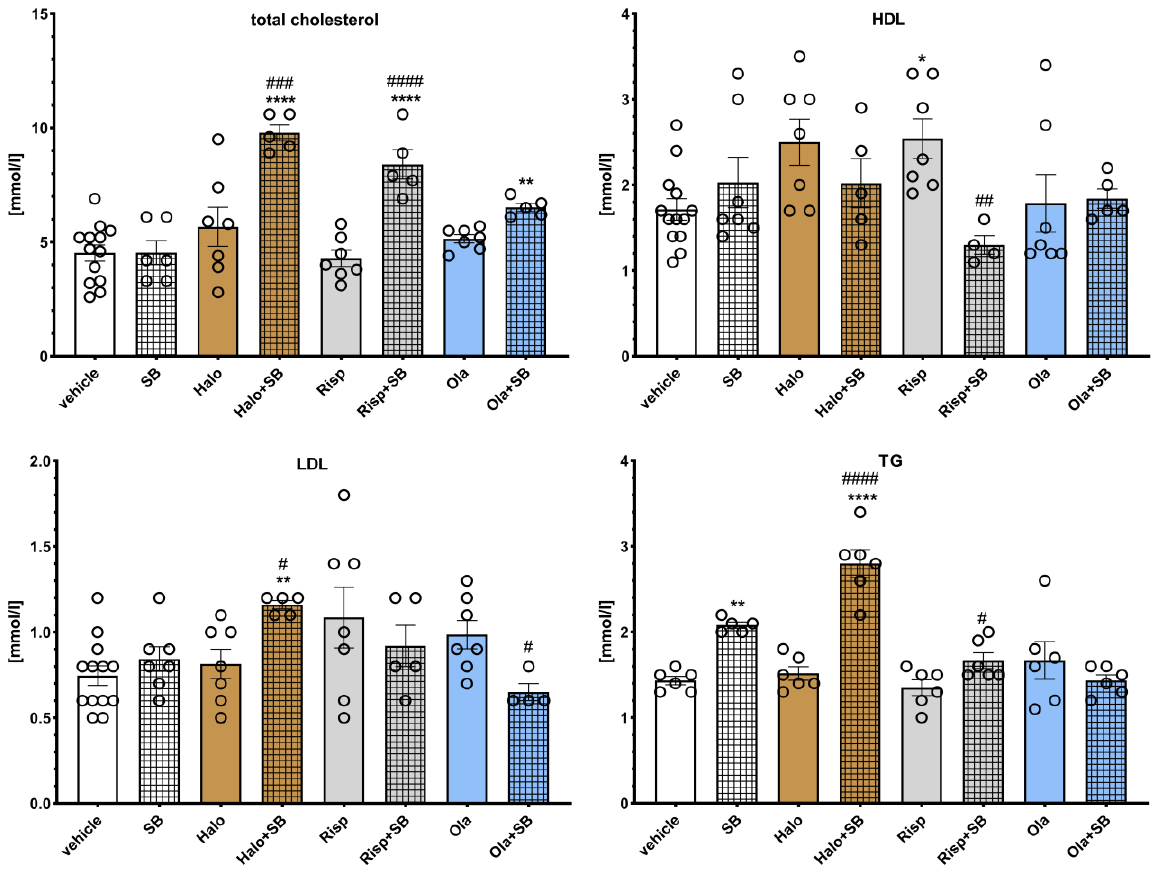
Figure 5. Effects of haloperidol, risperidone, olanzapine, and SB-742457, administered alone and in combinations, on serum levels of total cholesterol, LDL, HDL, and TG in rats. The results are presented as mean ± SEM; n = 6–12. * p < 0.05, ** p < 0.01, **** p < 0.0001 versus respective vehicle-treated group; # p < 0.05, ## p < 0.01, ### p < 0.001, #### p < 0.0001 versus the respective APD-treated group (two-way ANOVA followed by Bonferroni’s post hoc test). Halo, haloperidol 0.5